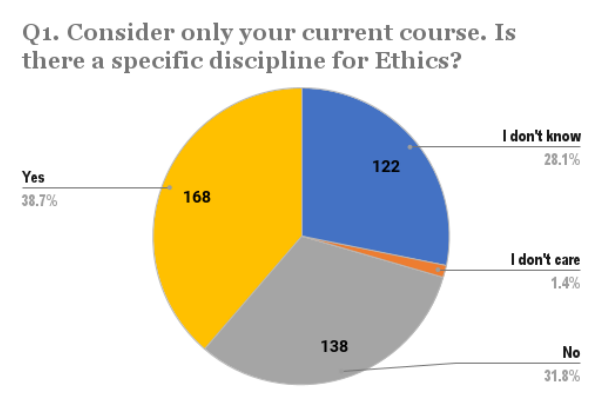
Figure 2. Perception about ethics disciplines.